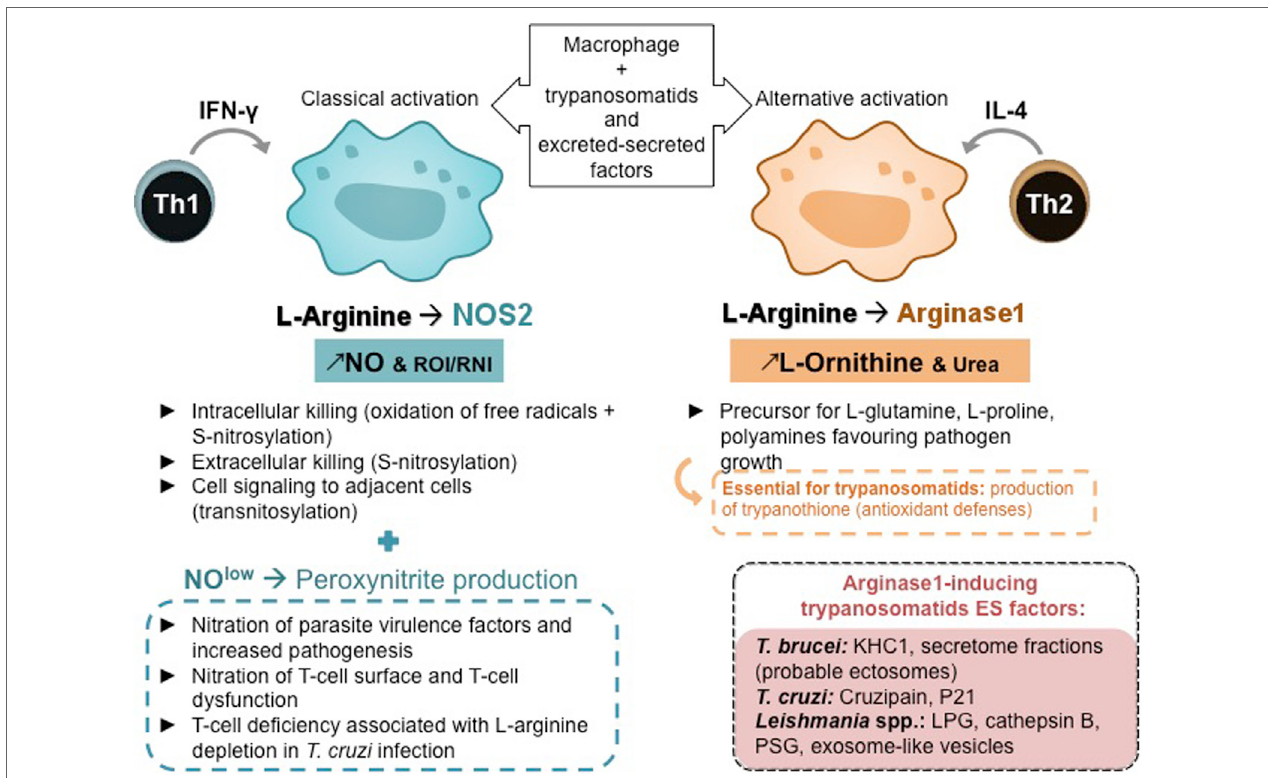
FiGURe 3 | Macrophage polarization, T-helper subsets, and l -arginine metabolism. Th, helper T lymphocyte; IFN- γ , interferon; IL, interleukin; NO, nitric oxide; ROI, reactive oxygen species; RNI, reactive nitrogen